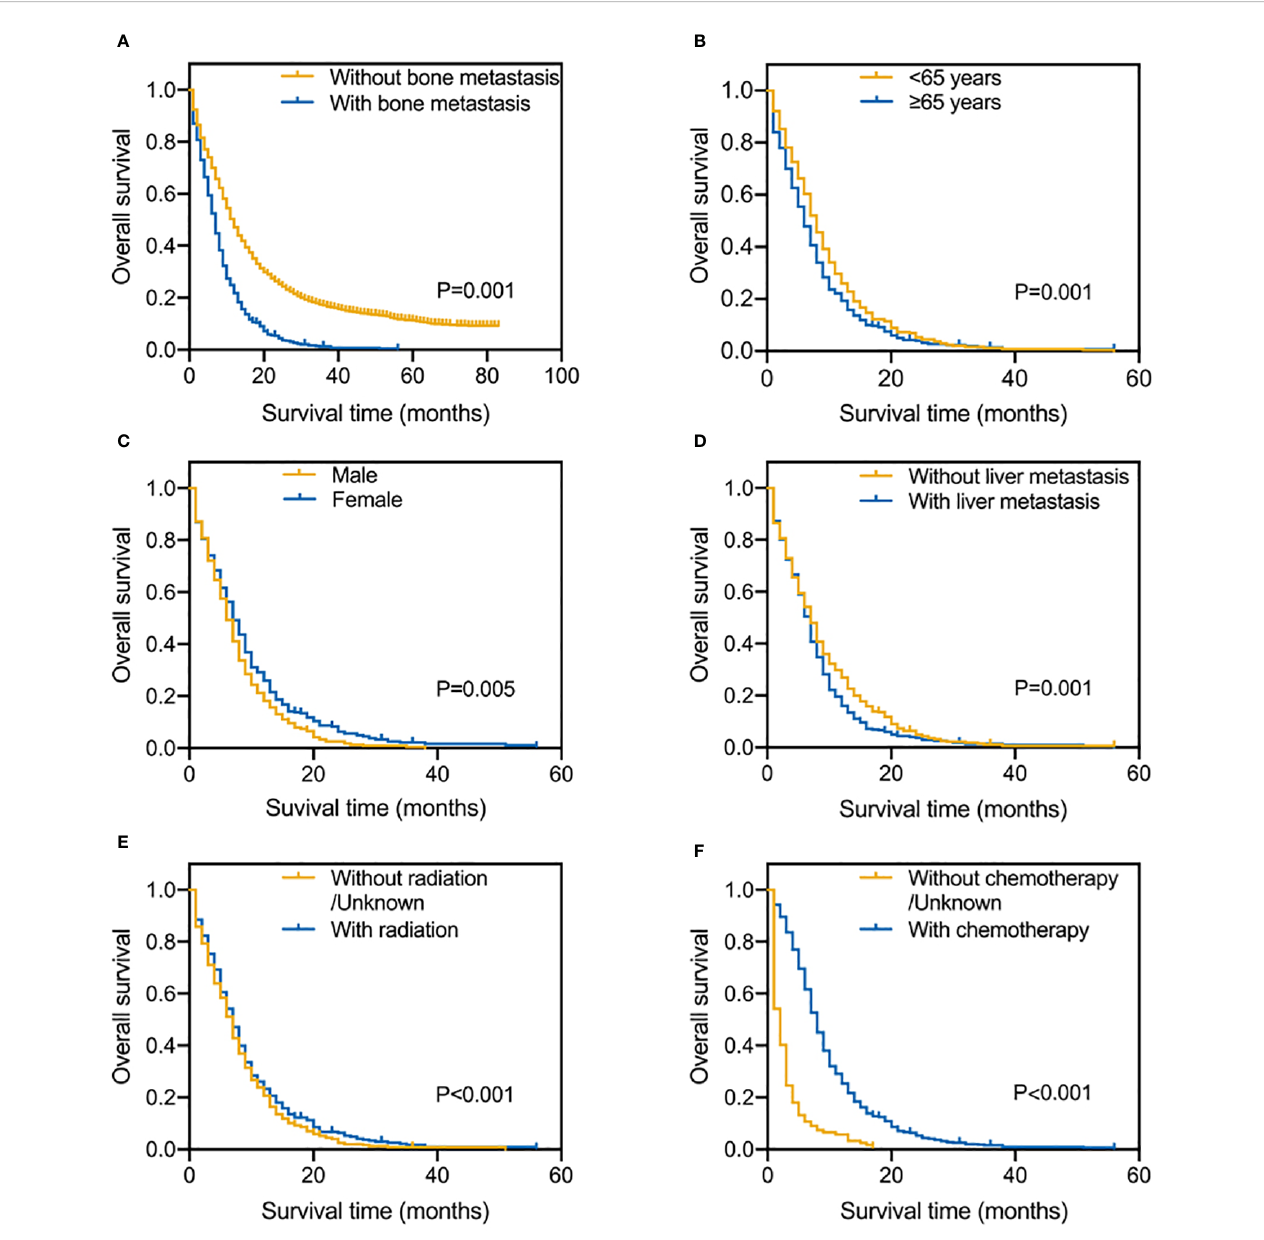
FIGURE 2 Kaplan-Meier survival curve analysis of SCLC patients with and without BM (A) ; Risk factors for SCLC patients with BM by the Kaplan-Meier survival curve analysis: age (B) , gender (C) , liver metastasis (D) , radiation (E) and chemotherapy (F)